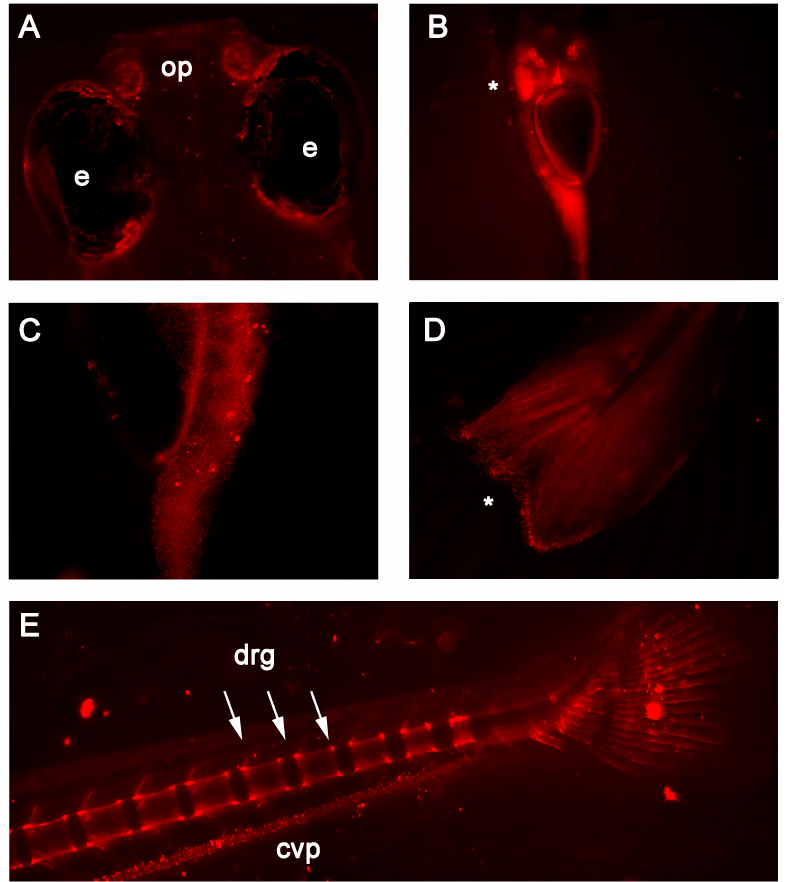
Figure 2. In vivo fluorescence detected in 7 and 14 days post-fertilization RedEfish. ( A ) mScarlet expression was unique to the olfactory pits (op) found in the RedEfish; however, some autofluorescence was detected in the pigment cells surrounding the eyes (e) in all embryos. ( B ) mScarlet expression was identified in the digestive tract, specifically the liver (as indicated by *). ( C ) More punctate expression was observed in the anterior gut region (ventral embryo positioning). ( D ) Punctate expression was observed also in the tail fin (as indicated by *). (E ) By 14 dpf, mScarlet expression was identified in the caudal vertebrae and dorsal root ganglia (drg) and was detected in the caudal vein plexus (cpv). Some autofluorescence was noted in both RedEfish and Casper